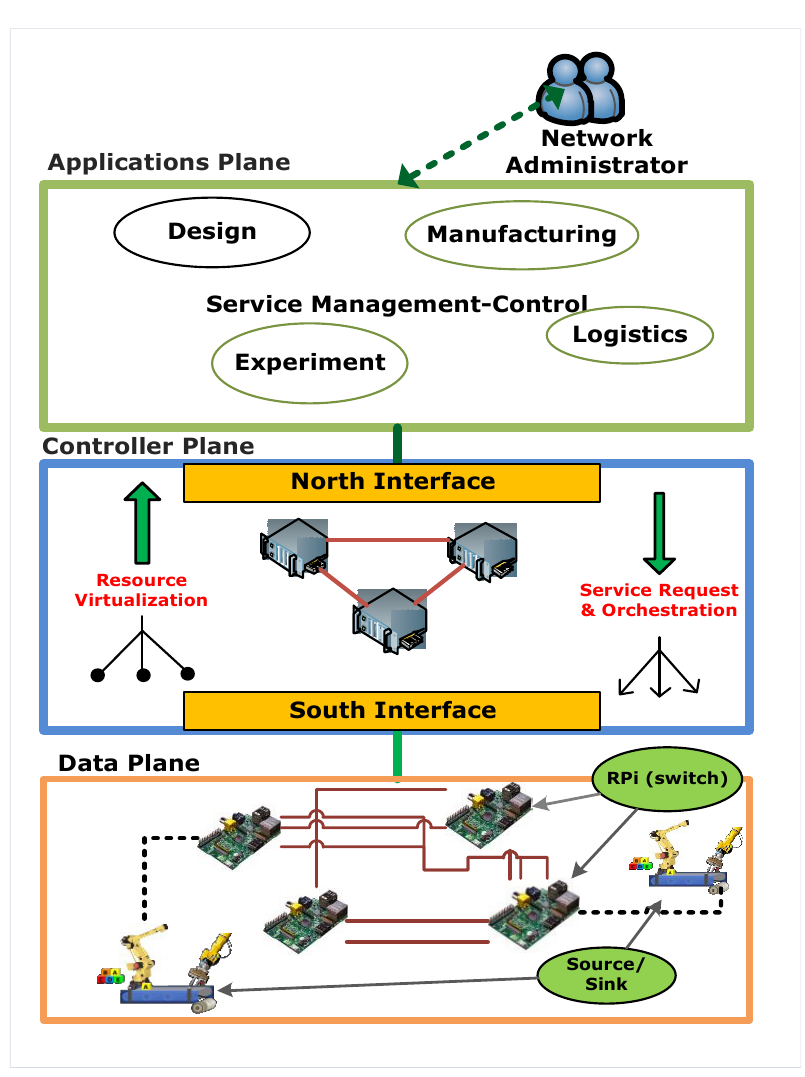
Figure 2. SDIAN communication framework.